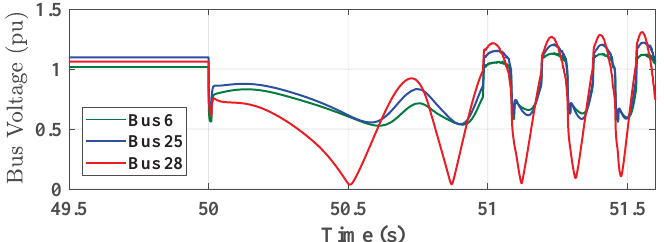
Figure 9. The PE-based power system frequency response to the G5 trip at t = 50 s for the system with high penetration of wind turbine (case study 3).